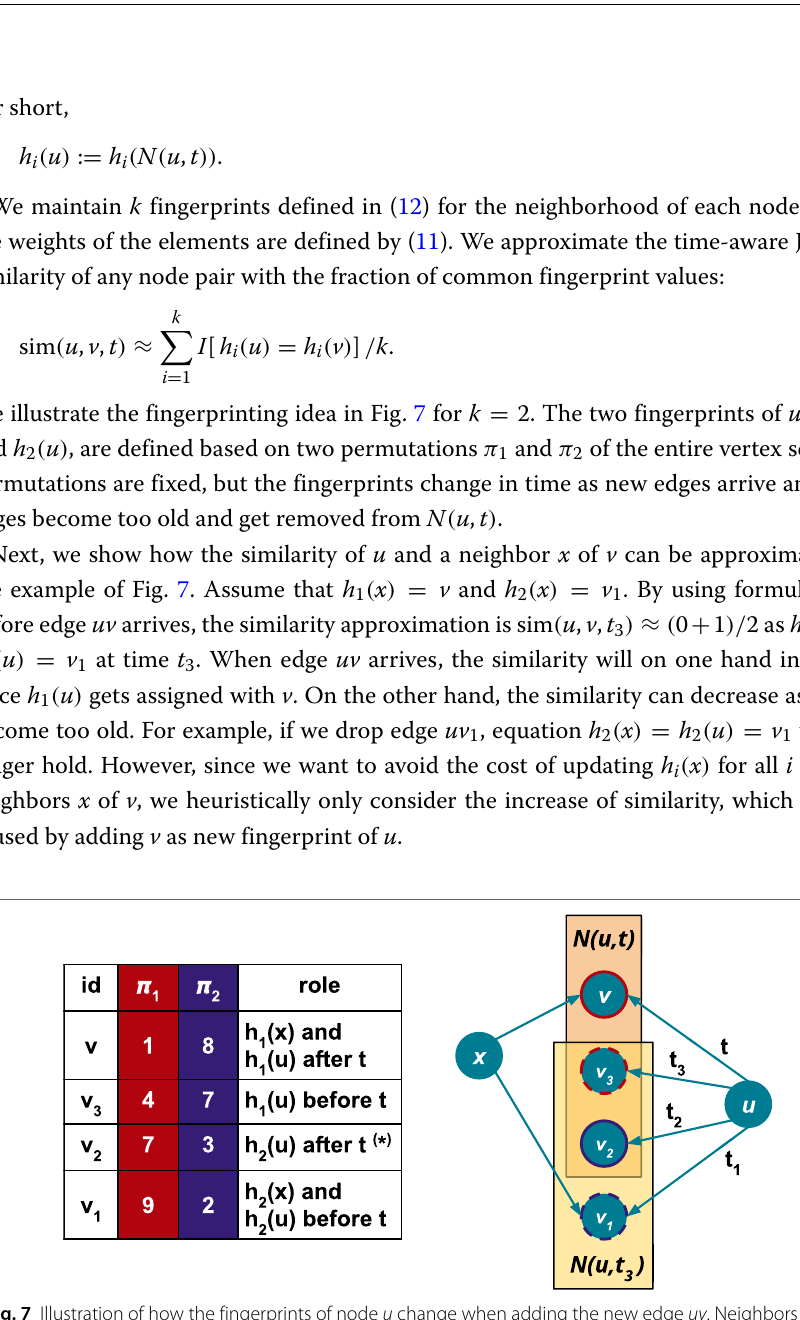
Table 2 Notations used in the second oder similarity algorithm uv the new directed edge that is being processed in the edge stream time of arrival of a multi-edge instance a permutation of the entire vertex set, fixed in time